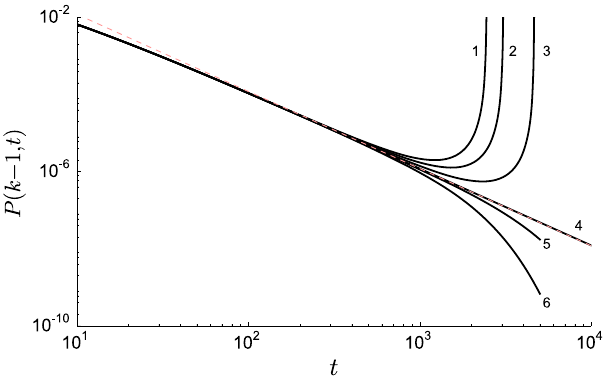
FIG. 5. Decay of P ð k − 1 Þ on a log-log scale for several values of h q i close to h q i c . Exactly at the critical point, the decay follows a power law with exponent − 2 . [For clarity, the final collapse of P ð k − 1 Þ for curves below the critical point is not shown.] Curves are plotted for the Erd ő s-Rényi graphs with the mean degree values (labeled 1 – 6) 3.350 905, 3.350 91, 3.350 915, which are below q c , 3.350 91887 (very close to q c ), and 3.350 92, 3.350 925, which are above q c . Dashed line is a power-law decay with exponent − 2